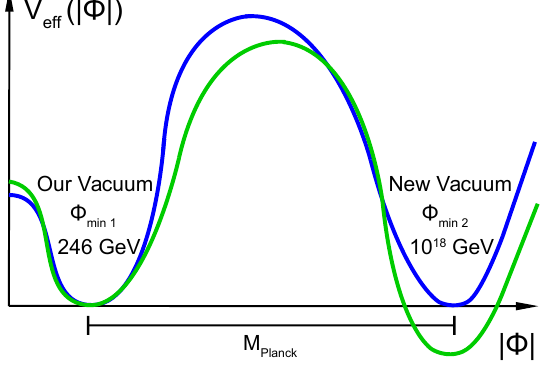
Figure 1. Minima of the effective Higgs potential in the pure Standard Model, which correspond to the first Electroweak “true vacuum”, and to the second Planck scale “false